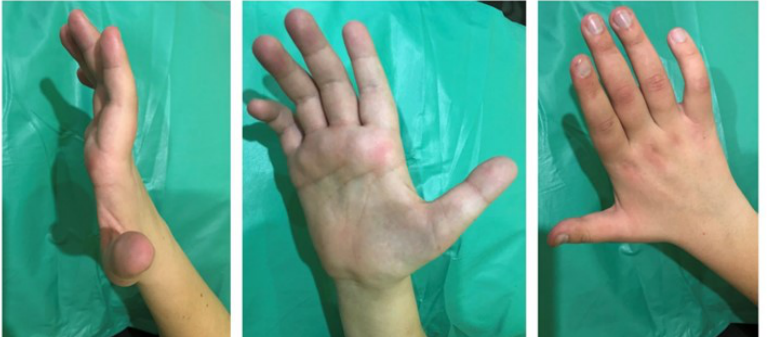
Figure 1. Mild flexion deformity of the fingers and hypotrophy of the muscles of the right hand in a 23-year-old man with Chiari malformation type 1-related syringomyelia. Thumb opposition strength decreased up to 2/5 points on the right hand and up to 4/5 points on the left hand. Metacarpophalangeal abduction strength of the fingers reduced up to 3/5 points on the right hand and up to 4/5 points on the left hand. Flexion strength of the second, third, fourth, and fifth fingers decreased up to 2/5 points on the right hand and up to 4/5 points on the left hand. Flexion and extension of the wrist slightly reduced on the right hand up to 4/5 points. The strength of the muscles of the forearms, shoulders, upper arm, neck, trunk, and lower extremities were normal (5/5 points). with left laterality. Bekhterev bone-abdominal reflex, deep abdominal reflex,